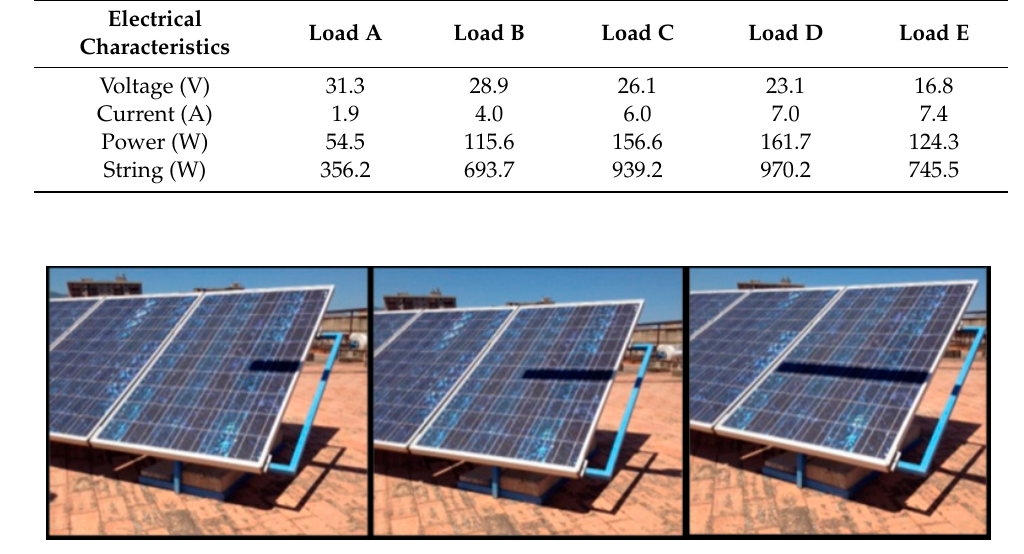
corresponds to one interruption of a line of cells; in case 2 shadow varies from 450 to 900 cm 2 , which